Question: Describe this figure in one sentence.
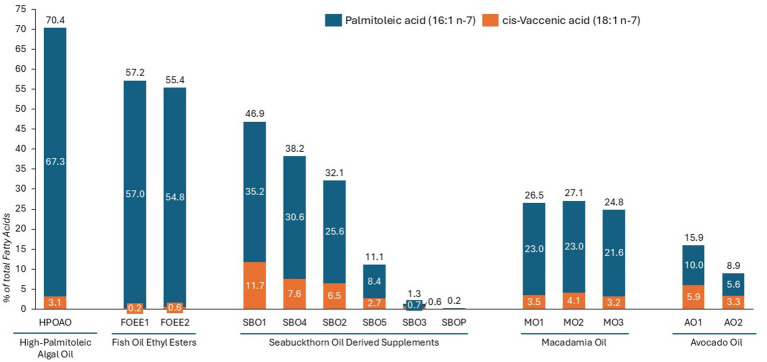
Answer: Fatty acid profile, average and standard deviation of duplicate analyses expressed in % of total FA, of fish oil ethyl ester (FOEE) concentrate, high-palmitoleic acid algal oil (HPOAO), seabuckthorn oil-based dietary supplements (SBO and SBOP), macadamia oils (MO), and avocado oils (AO).